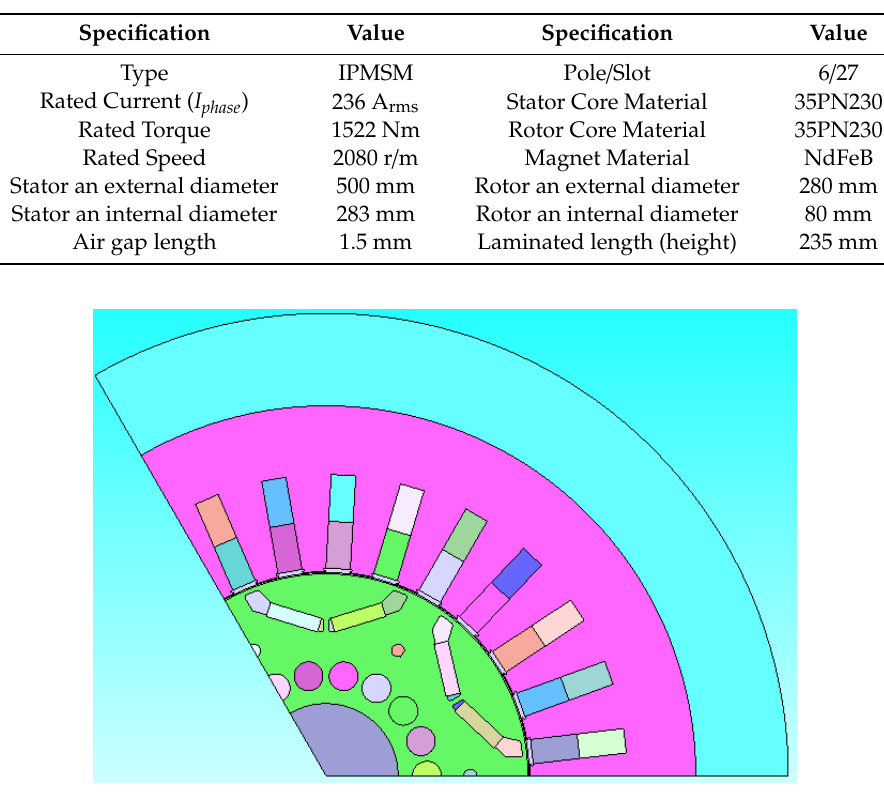
Figure 3. The cross section of interior permanent magnet synchronous motor (IPMSM) used in this paper.